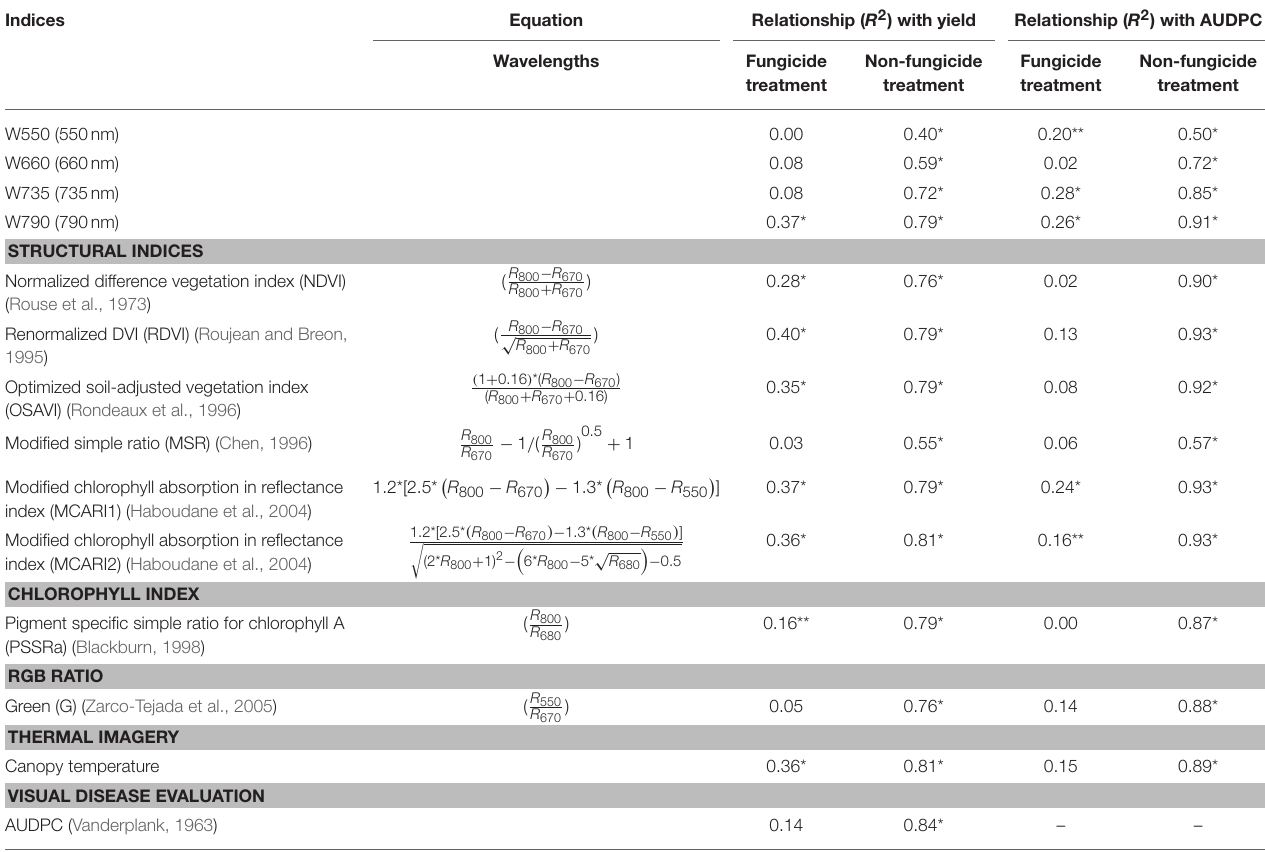
TABLE 2 | Relationship between grain yield of maize hybrids and area under the disease progress curve (AUDPC) of tar spot complex with areas under different wavelengths, vegetative indices and thermal imagery under fungicide and non-fungicide treatments. Indices Equation Relationship ( R 2 ) with